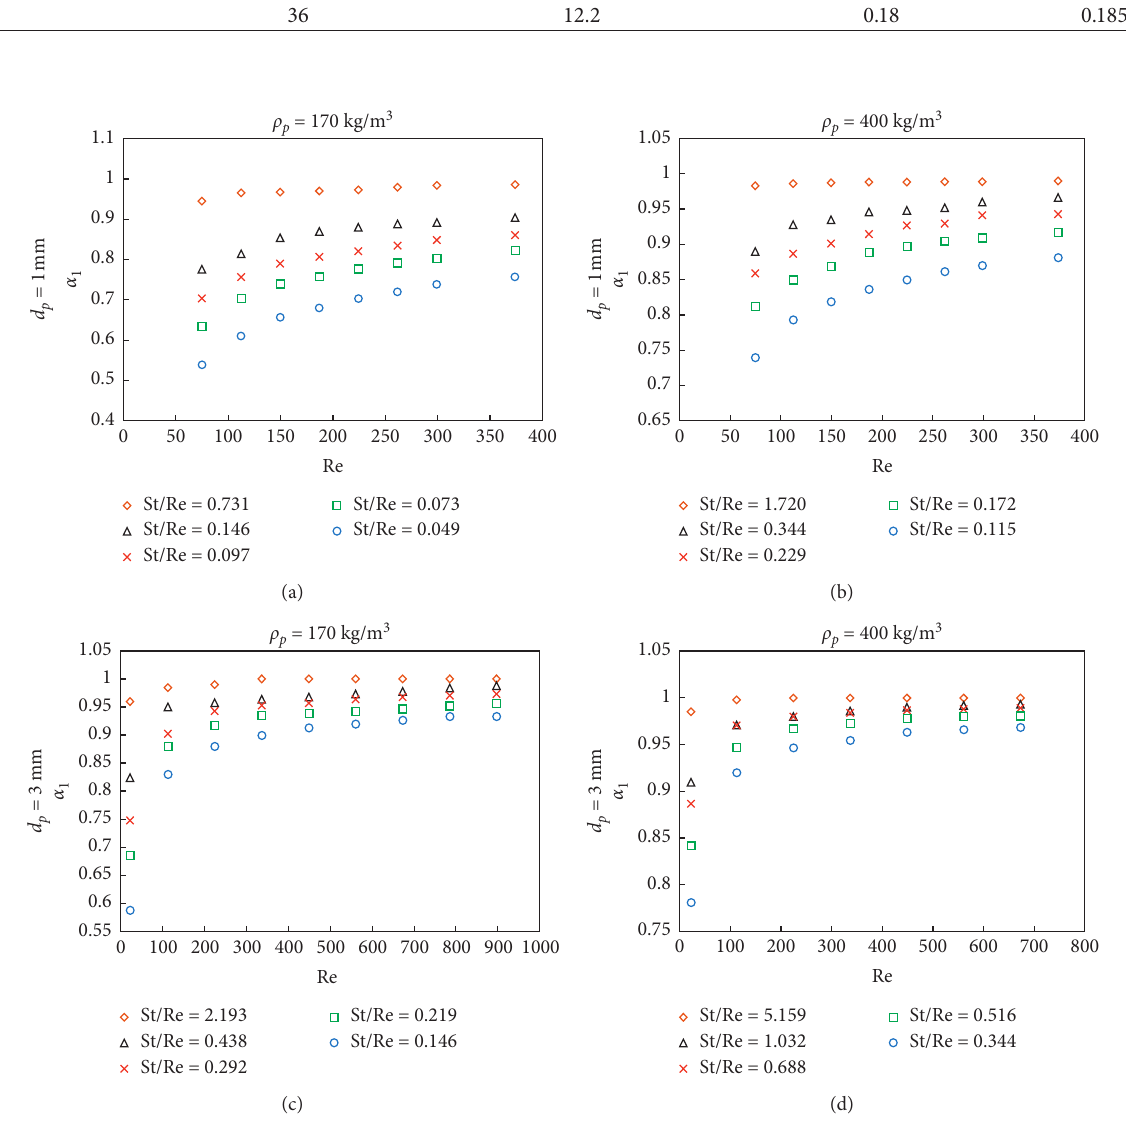
Figure 2: The collision efficiency ( α ) of the snow particles with varying snow particle diameter ( d p ) and density ( ρ p ) as a function of 1 dimensionless Re and St / Re numbers. (a) d p � 1 mm, ρ p � 170kg/m 3 ; (b) d p � 1mm, ρ p � 400kg/m 3 ; (c) d p � 3mm, ρ p � 170kg/m 3 ; (d) � 3mm, ρ � 400kg/m 3 . The density, velocity, and geometry of the snow particles, besides the geometry of the cylinders, are momentous d p p factors in determining the collision efficiency of the snow particles to the